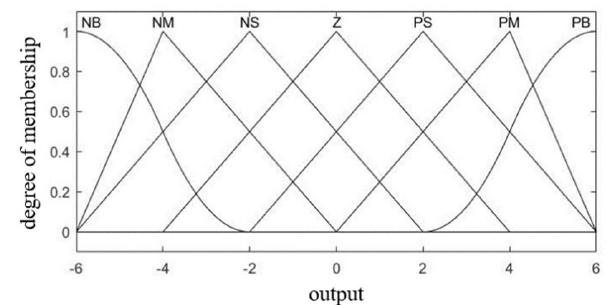
Figure 12. Membership function of output.